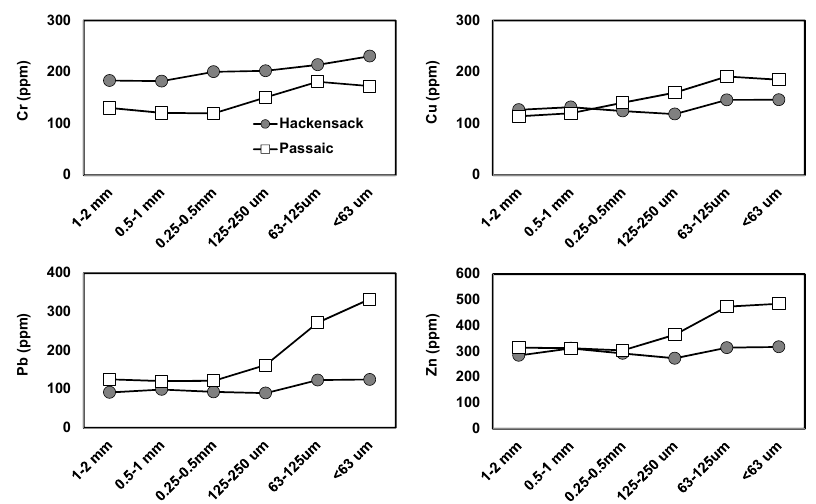
Figure 6. Average concentrations of heavy metals in sediments collected from the Hackensack ( n = 8) and Passaic ( n = 7) Rivers in summer 2015 as a function of sediment grain sizes (<2 mm grain sizes). Rice et al. (1999) reported trace element concentrations in 541 streambed-sediment samples (<63 μ m size fraction; silt and clay) collected from 20 study areas across the contiguous United States [46]. For the same grain size fractions (<63 μ m), the average concentrations of As (14 ± 2 and 6 ± 5 ppm) in the Hackensack and Passaic River sediments were similar to the medians of As (5–21 ppm) in the streambed sediments from nonurban areas that are least affected by human